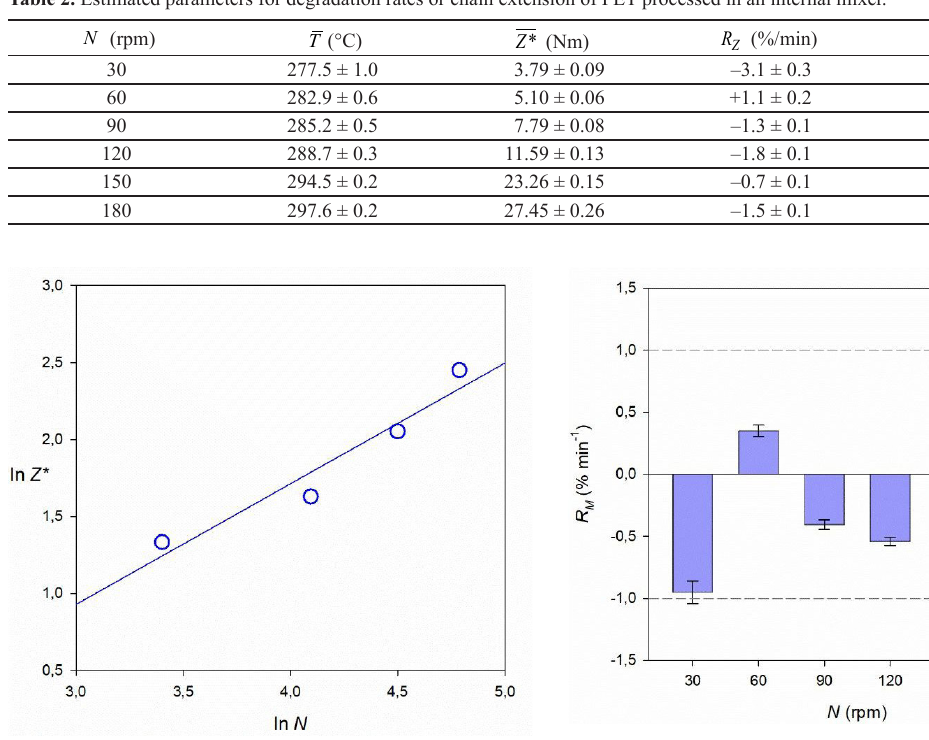
Figure 7. Relative rate of change of the weight average molar mass for different speeds of rotation. The dashed lines delimit the